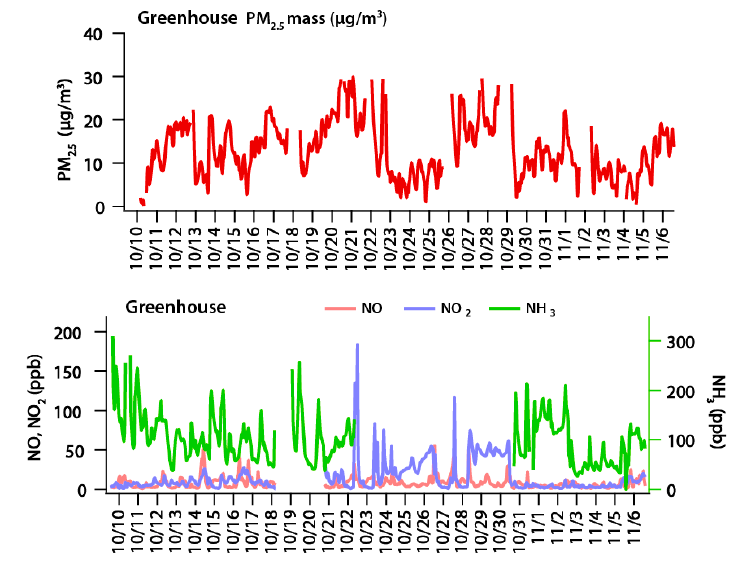
Figure 4. Concentrations of PM 2.5 , NH 3 , NO and NO 2 measured in a green